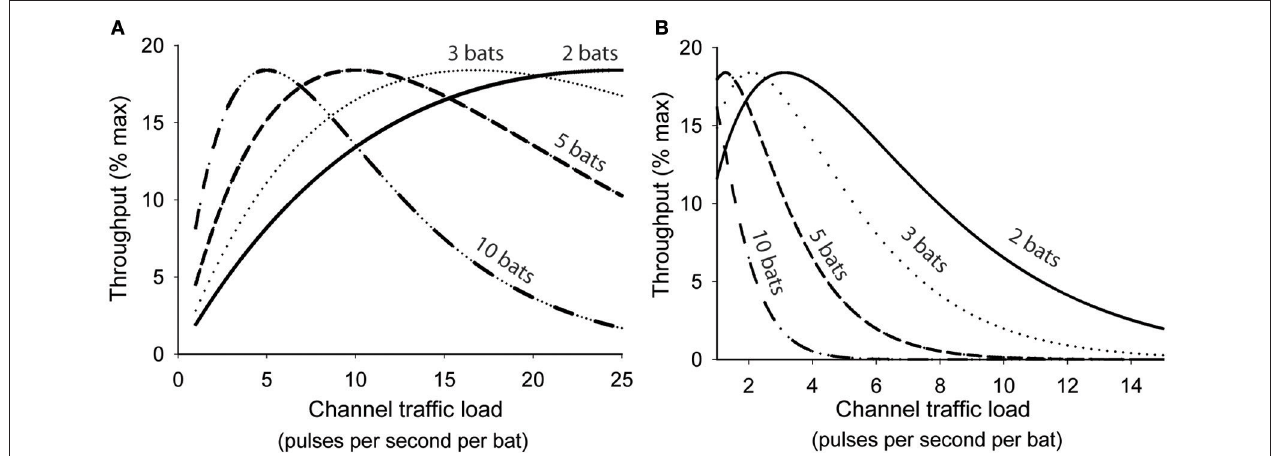
FIGURE 3 | Interactive effects of population density and emission rates on theoretical information throughput ( S ) of a shared acoustic communication channel following the function S = λ e 2 λ , where λ = r τ n . (A) calculates information throughput assuming a conservative overlap window ( τ ) of 10ms while (B) assumes an empirically-determined